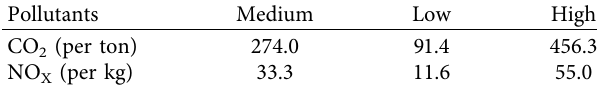
Table 2: Overview of emission costs of different pollutants ( ￥ ). Pollutants Medium Low